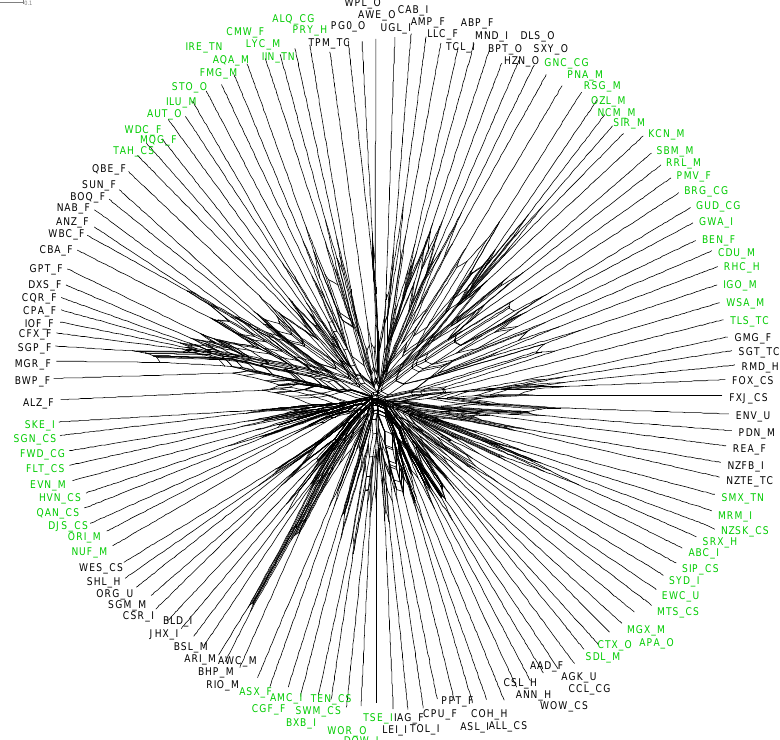
Figure 3. Period 2 neighbor-Nets splits graph with 10 clusters. A one or two letter code has been appended to each stock’s three letter ticker symbol to indicate what industry group it belongs to using the codes assigned in Table